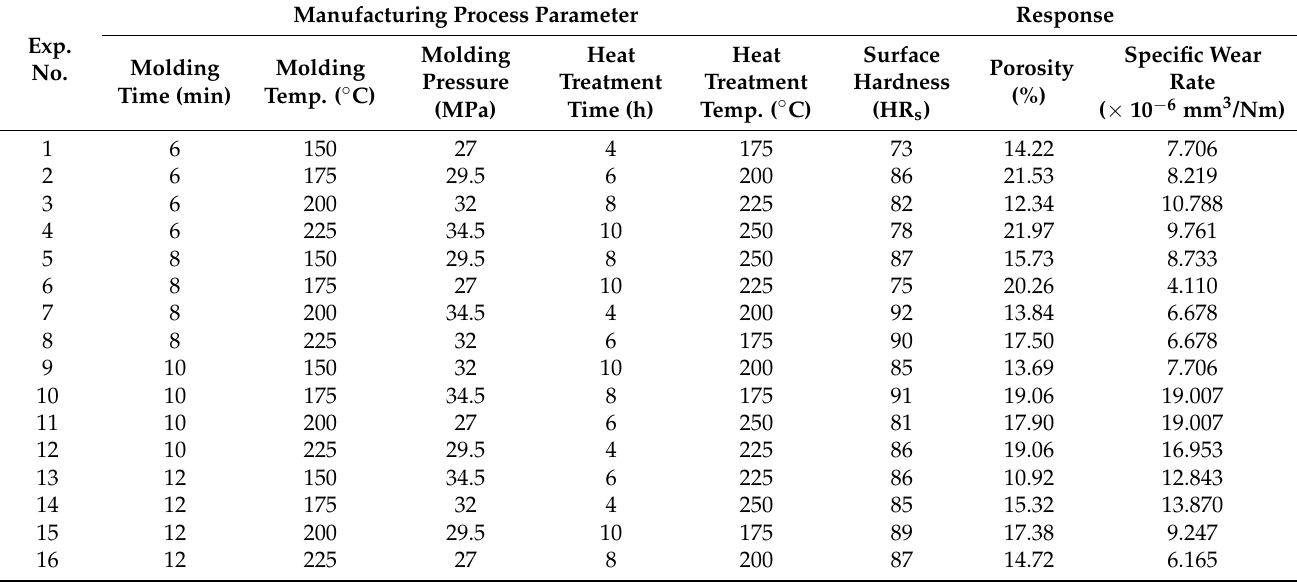
Table 1. Experimental design plan along with the measured responses for case study 1 [15].